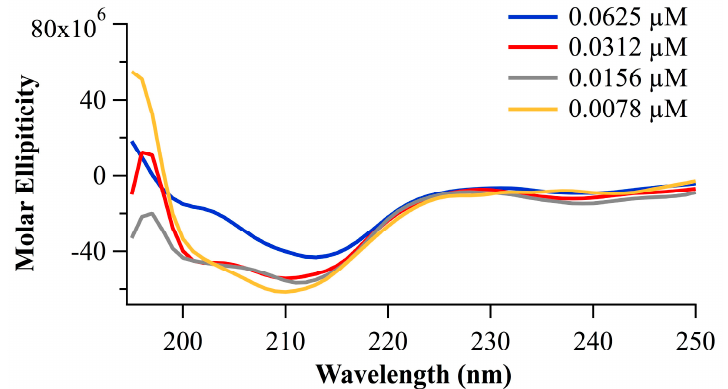
Figure 4. Circular Dichroism of the tripeptide (Suc-APA-AMC) at various concentrations ranging from 0.0625 to 0.0078 μ M.